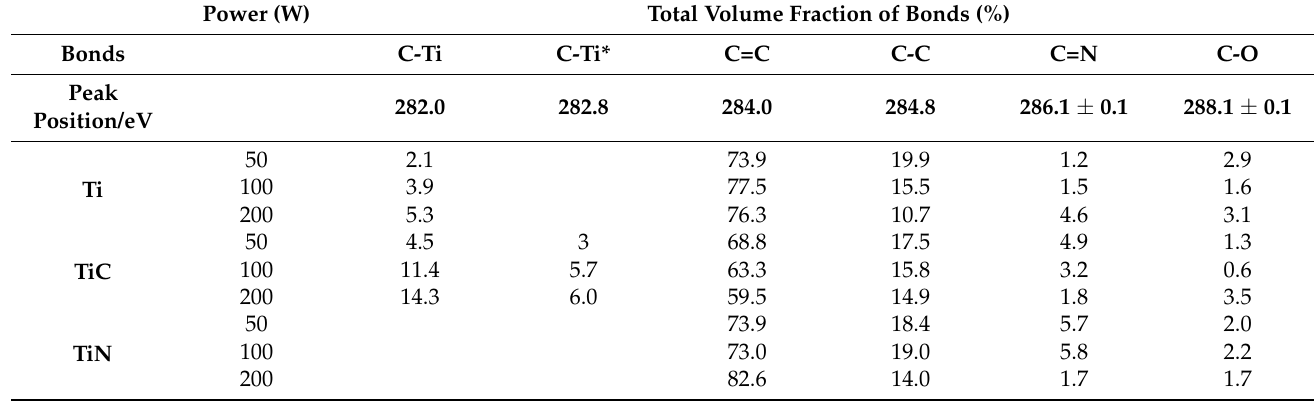
Table 3. XPS analysis results of C 1